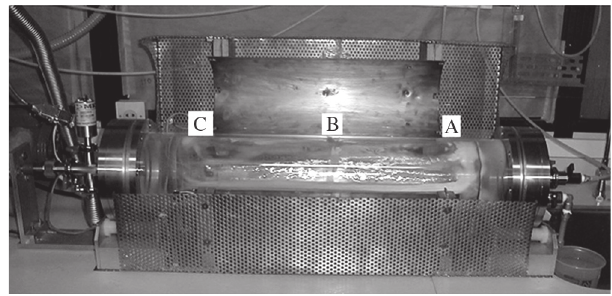
Figure 1. Tubular reactor showing the sample positions A) right, B) center and C) left on the electrode.